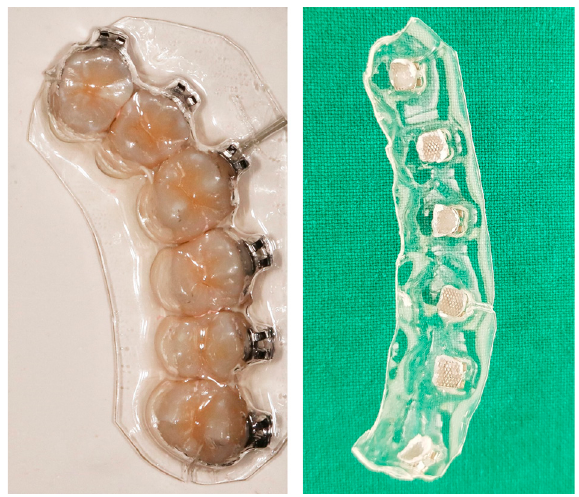
Figure 2. Transfer tray made by vacuum formed